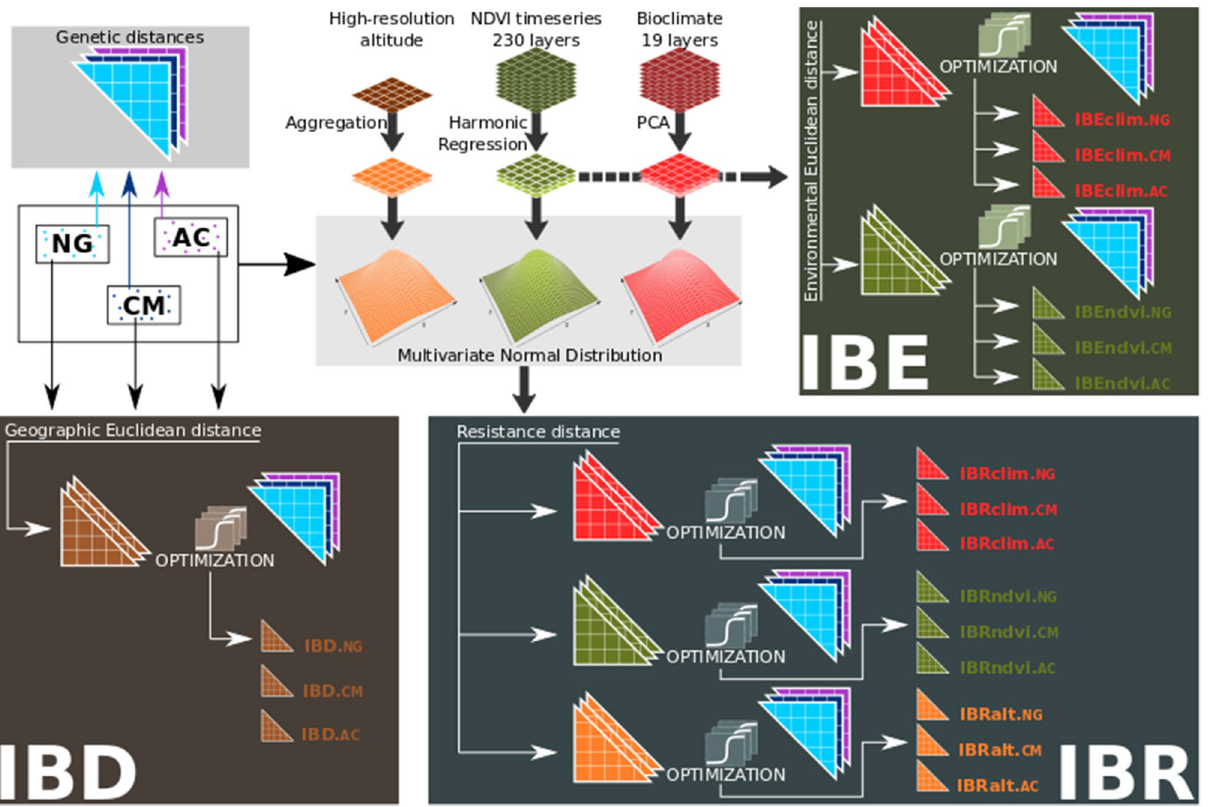
Figure 5. Landscape genetics analyses workflow used to derive optimized variables representing the different isolation models (IBD, IBR, and IBE). Two parameters of a logistic curve (curvature and inflection point) were applied to the isolation by distance matrix and optimized with genetic algorithms. The objective of optimization is the maximization of the logLikelihood from a GLS regression. Note that this workflow is for a single genetic distance type, thus, it was executed twice for the R QG and R TRI genetic distances. The figure was created with Inkscape software (version 1.0.2; https:// inksc ape.